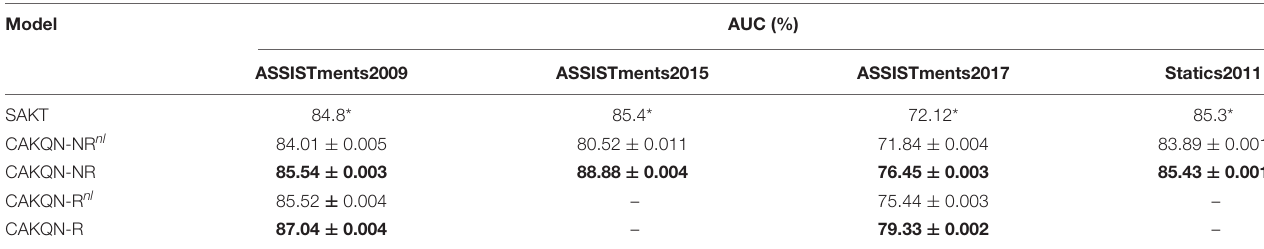
TABLE 4 | Experimental comparison between CAKQN and variants with other attention mechanism.